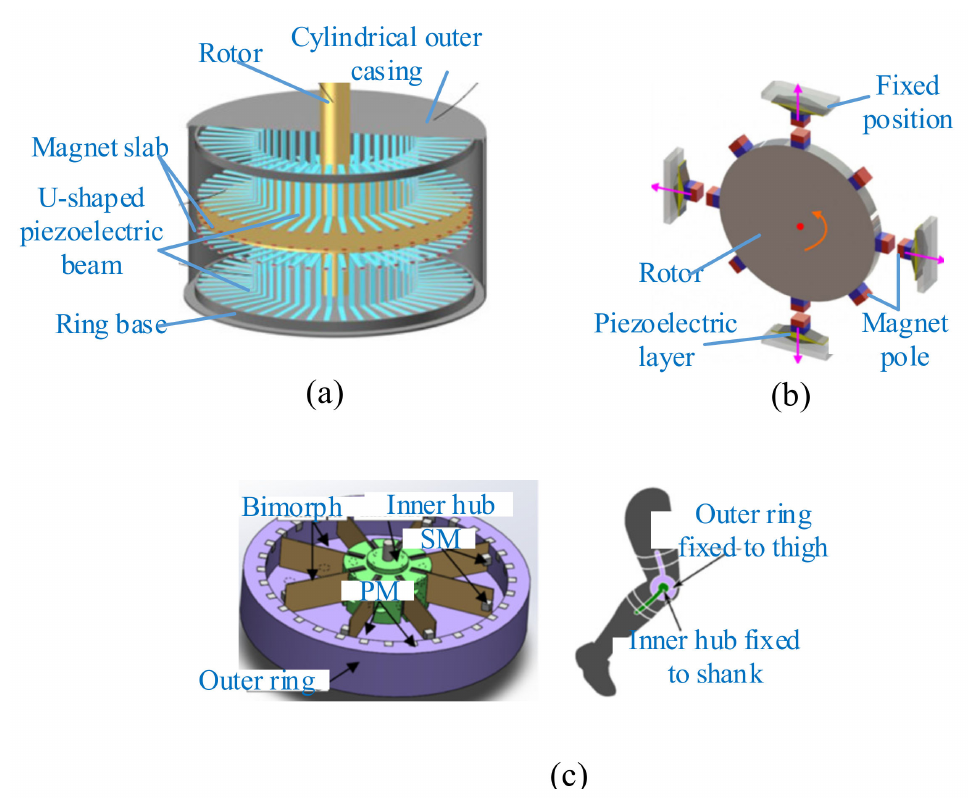
Figure 15. Magnetic plucking harvesters with multiple piezoelectric beams. ( a ) A U-shaped piezoelectric coupled harvester (reproduced with permission from [195]; published by Elsevier, 2019). ( b ) A rotational energy harvester (reproduced with permission from [196]; published by IOP, 2017). ( c ) A piezoelectric knee-joint harvester (reproduced with permission from [197]; published by IOP,